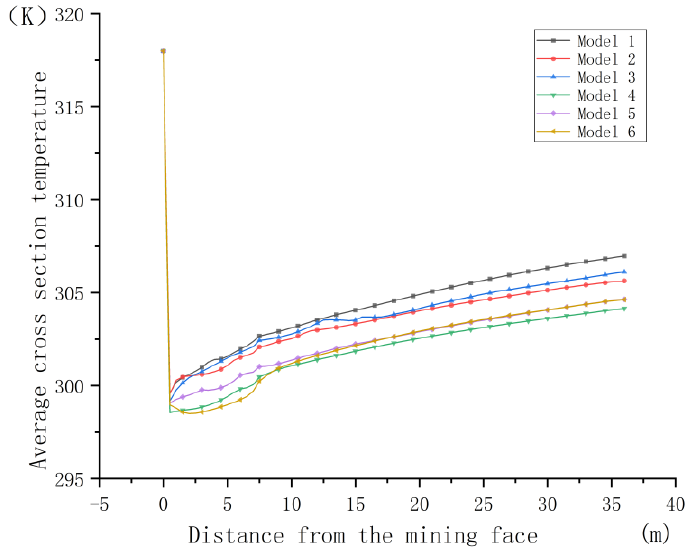
Figure 12. Models 4–6 section average temperature curve.